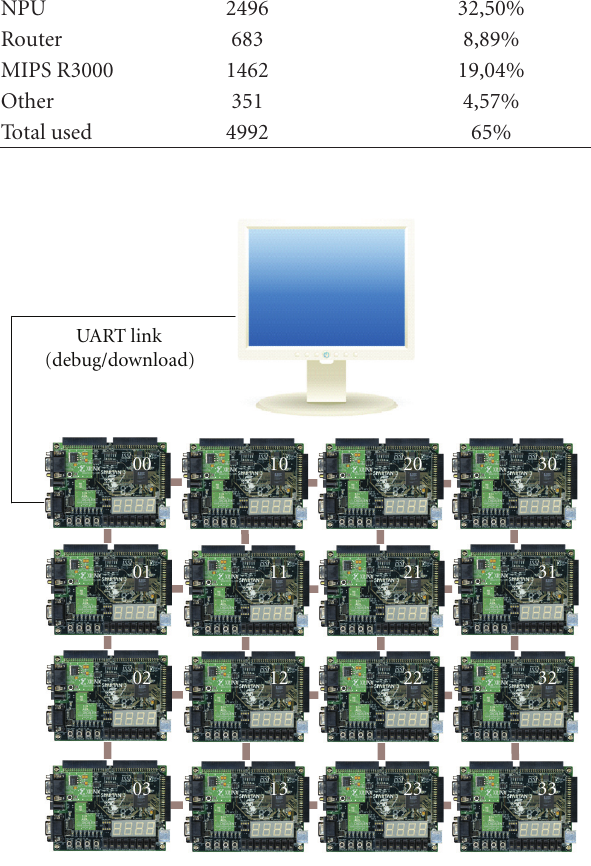
Figure 16: Array of 4 × 4 NPU multiboard. Table 4: Operating system time and memory costs (KB)